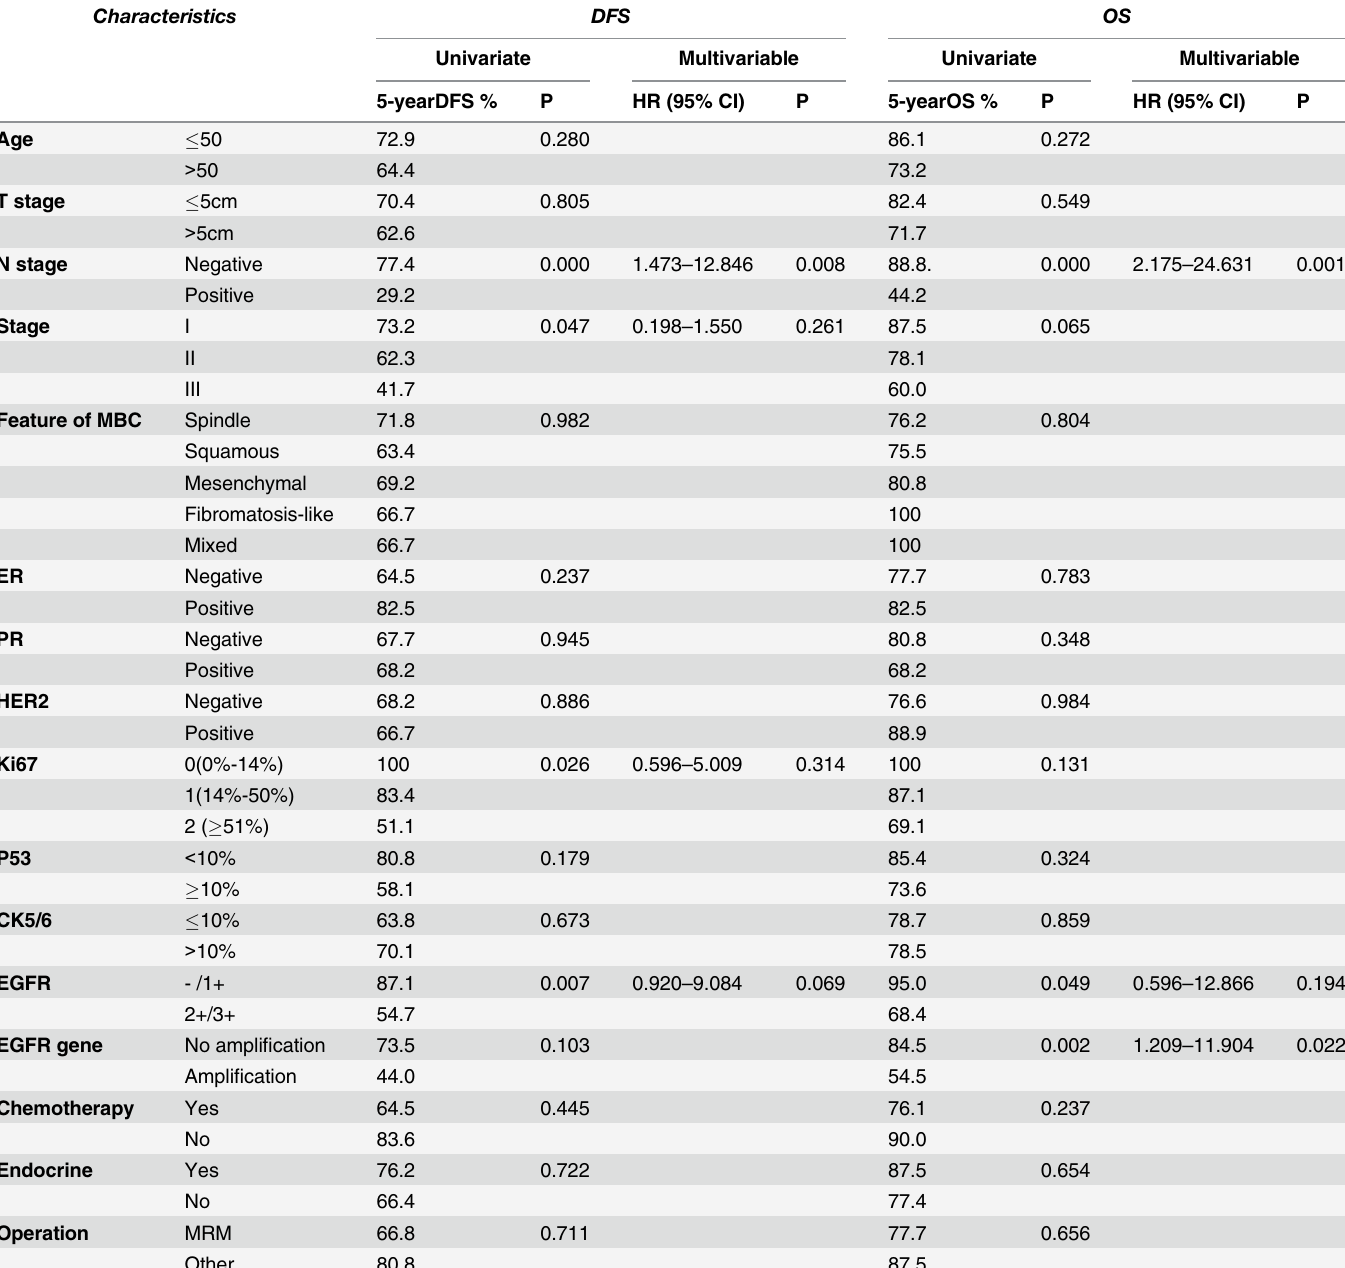
Table 6. Univariate analysis and multivariate analysis of MBC patient ’ s survivals.